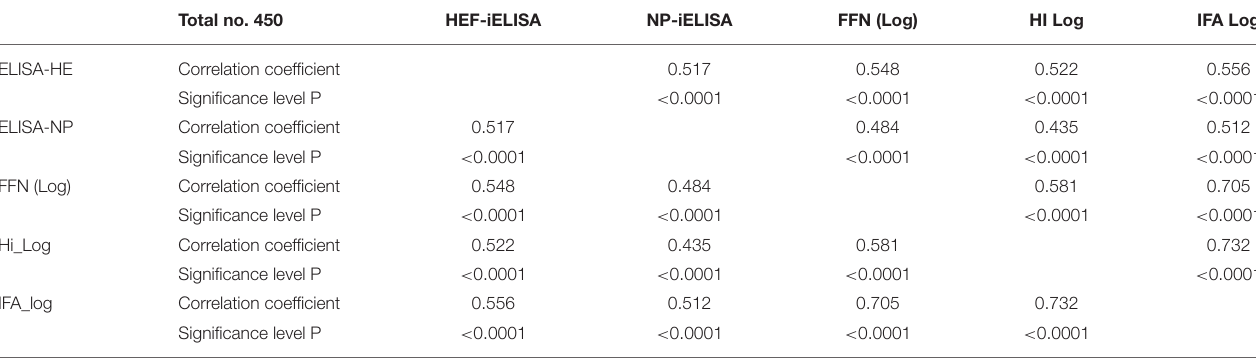
TABLE 1 | Pearson correlation coefficients for diagnostic assays between HI results after log-2 transformation and FFN. Total no.